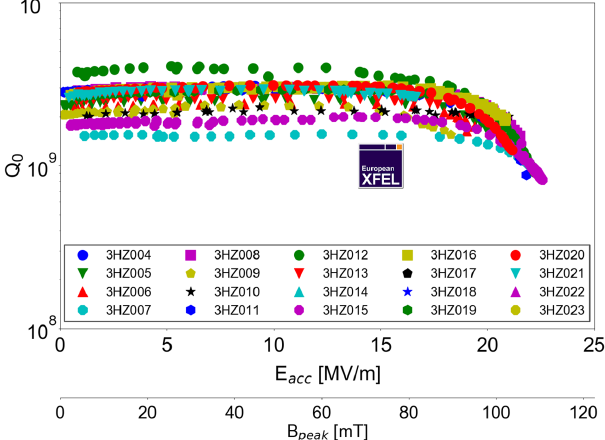
FIG. 1. Power rises for the 20 series production EXFEL 3.9 GHz cavities at 2 K. The qualification values ( E Q 0 ¼ 10 9 ) are also